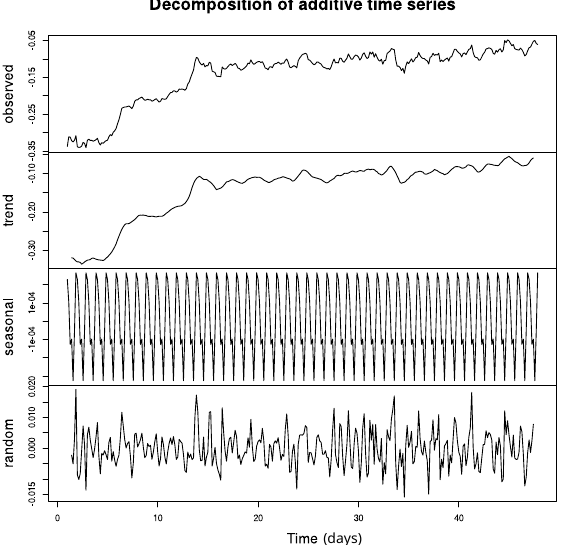
Figure A2. Year–Long time series of daily averaged compounded sentiment polarity of COVID-19-related tweets, utilizing RoBERTa in Mexico . Shown is the decomposed sentiment analysis: the averaged time series, trends, weekly seasonality, and random data. The time axis is shown in days, starting from